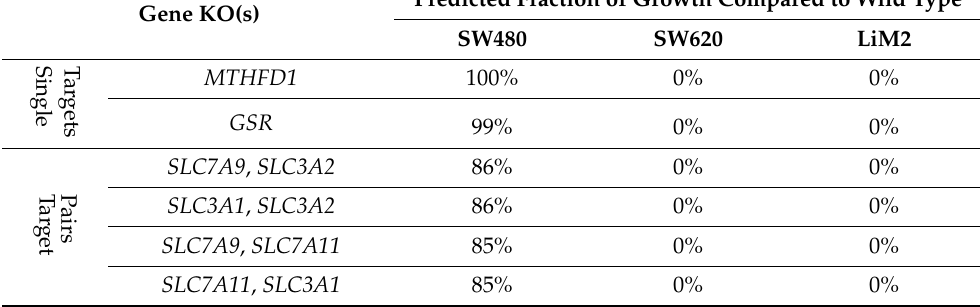
Table 1. Most promising metabolic targets identified from the cell-specific GSMMs. List of the individual paired target genes and their simulated effect on growth rate, expressed as percentage of growth of the simulated KO vs. wild type of the same cell line. Predicted Fraction of Growth Compared to Wild Type Gene KO(s) SW480 SW620